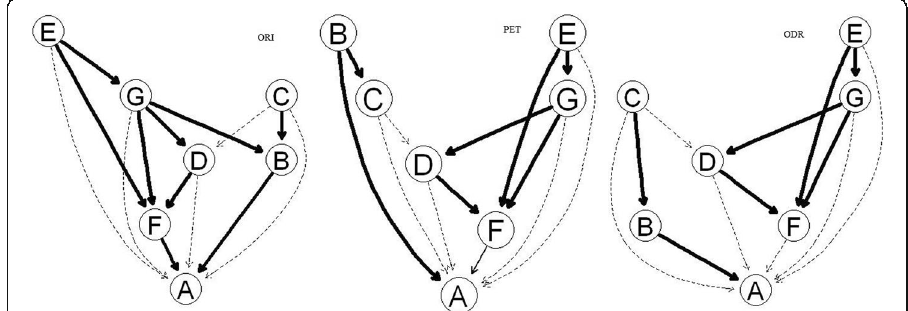
Fig. 3 The extracted Bayesian network for returns in each sector, obtained by the score-based algorithm. The solid/dashed lines refer to statistically significant/insignificant arcs, respectively. The letters represent A r